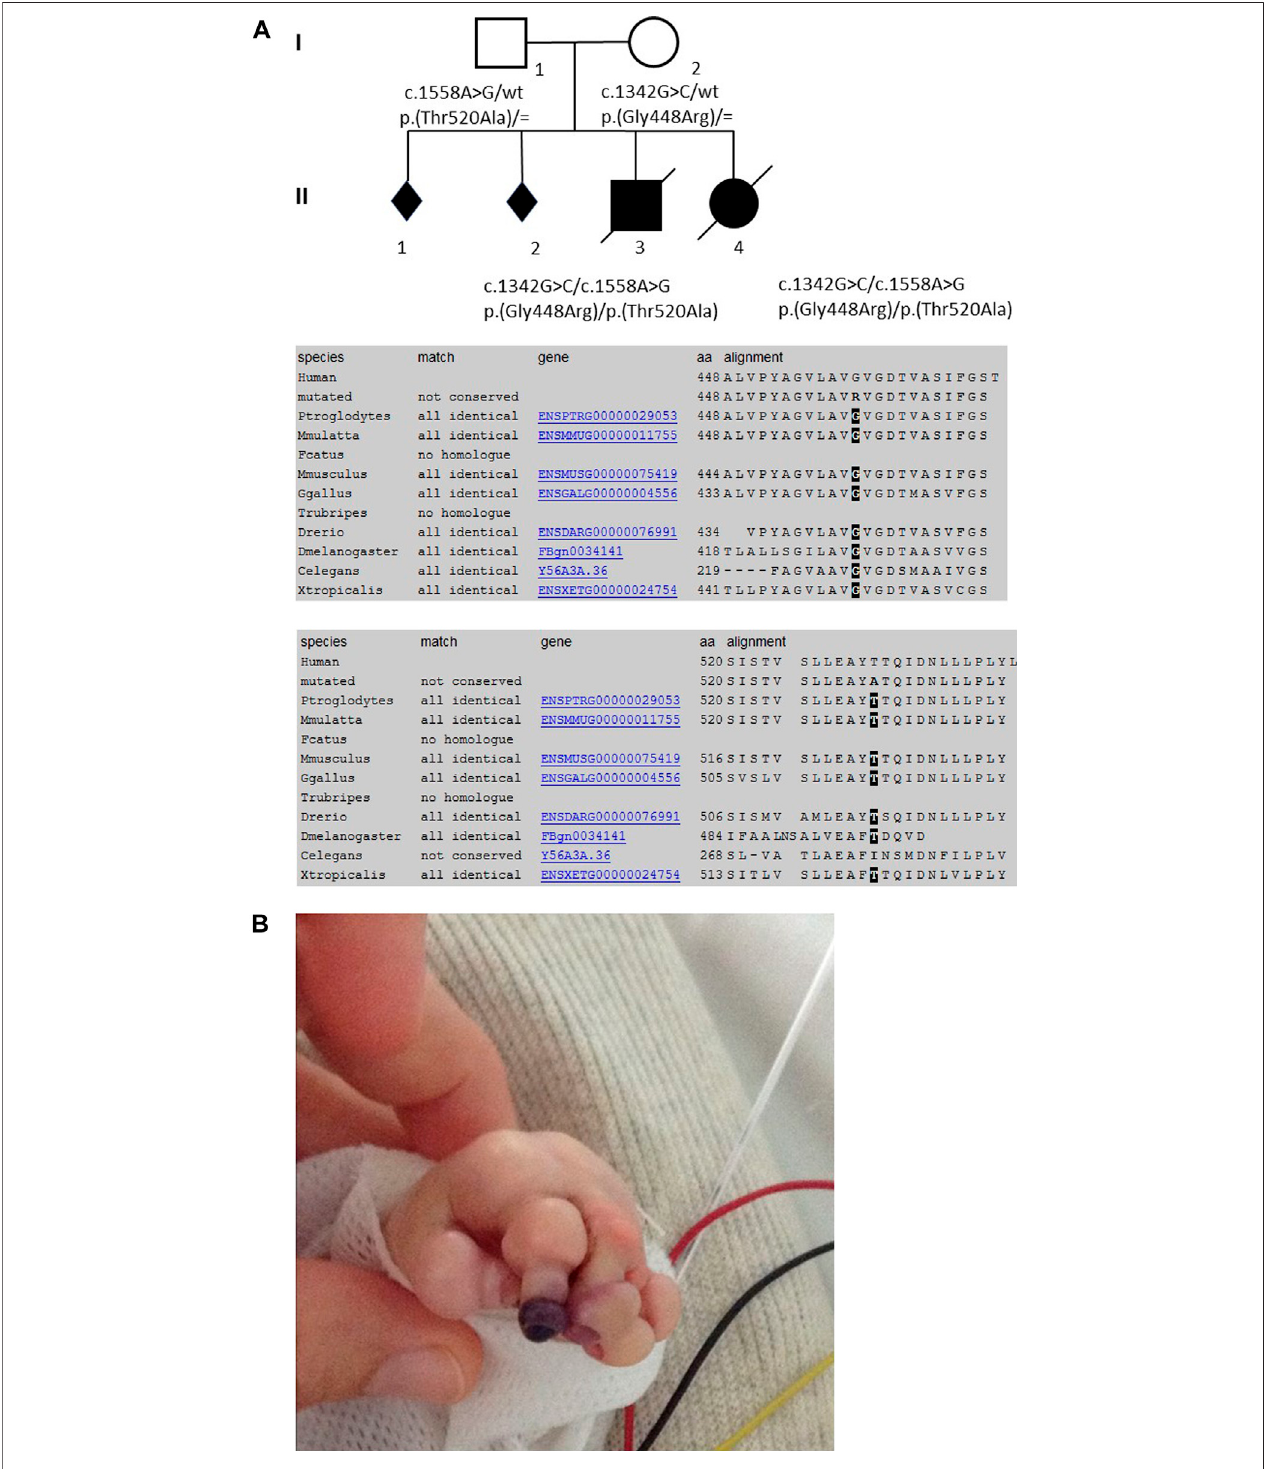
FIGURE 1 | Pedigree of the family, conservation of the AAs among the diverse species (from MutationTaster, www.mutationtaster.org), and skin manifestations of the fi rst child in the neonatal period.